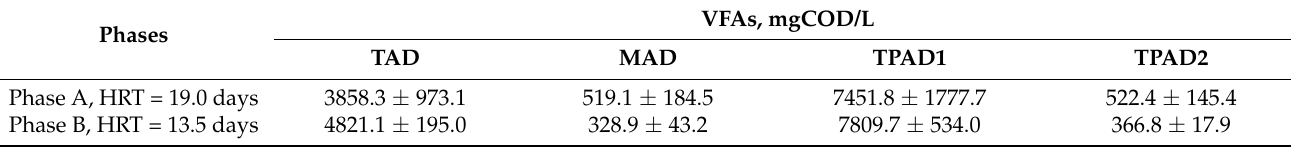
Table 3. The VFA concentration.